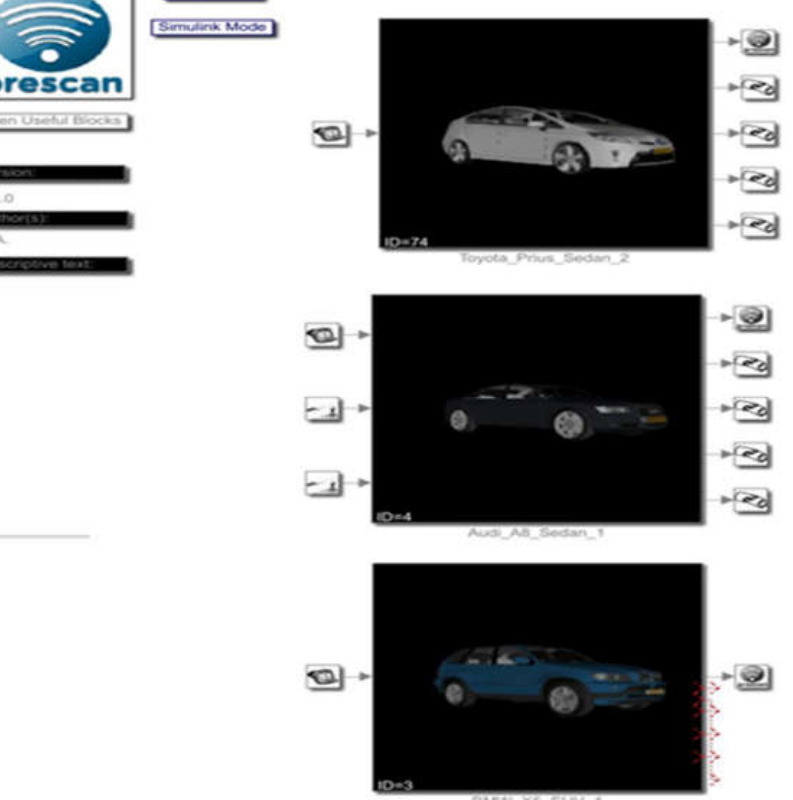
Figure 6. Compilation sheet in MATBLAB/Simulink.